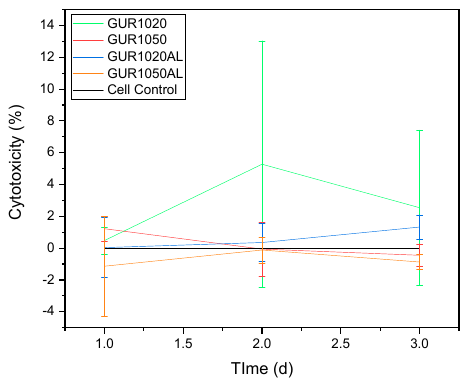
Figure 11. LDH test overview normalized to cell control, N = 15.